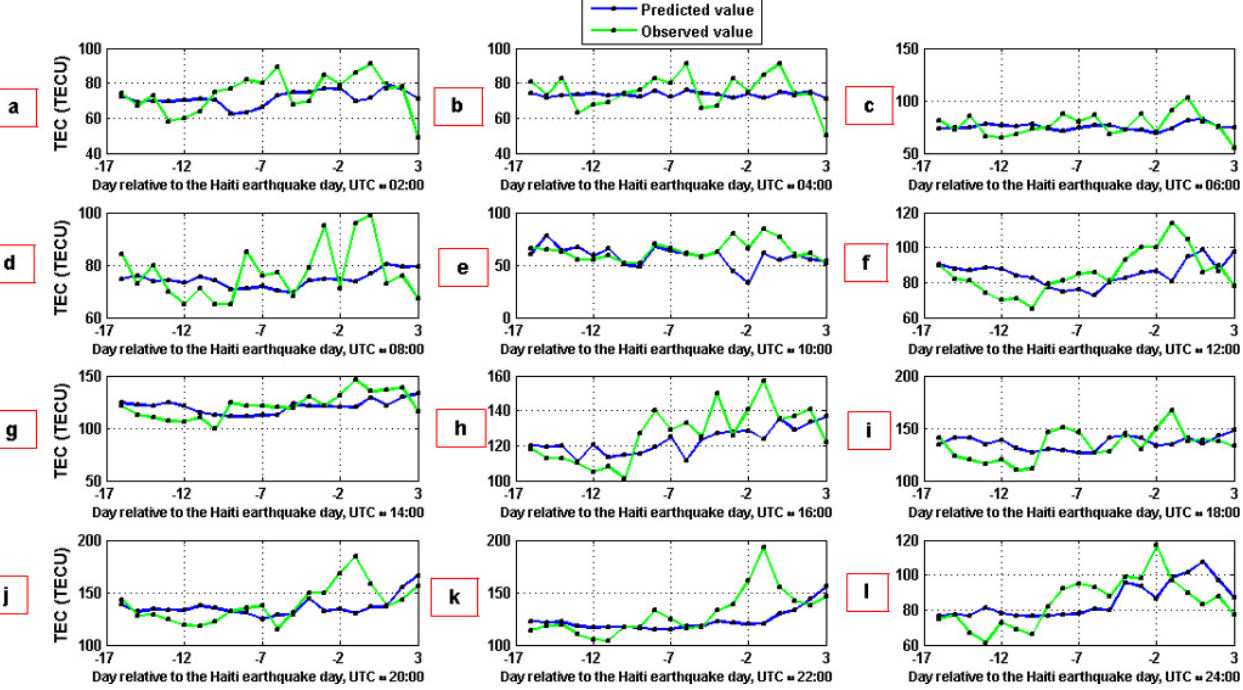
Fig. 6. Variations of the observed (green curve) and predicted (blue curve) TEC values on days selected as testing set at different universal times. The x-axis represents the day relative to the Haiti earthquake